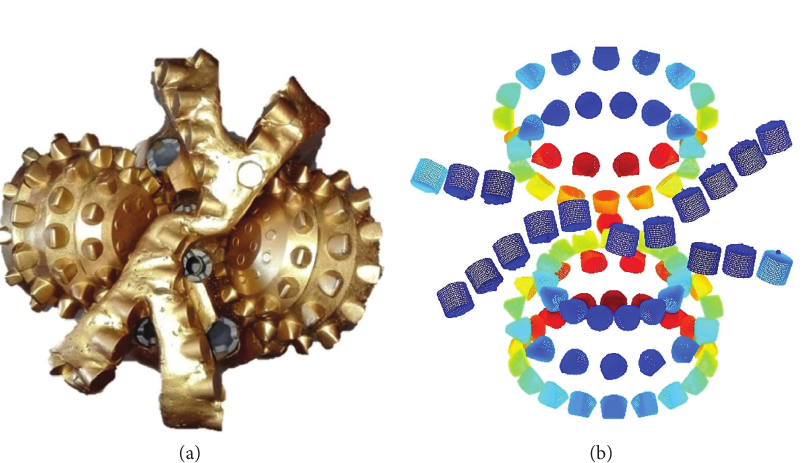
Figure 7: Diagrams of the 8-1/2 inch, 2+4 type composite bit (a) Composite bit physical model. (b) Composite bit simulation